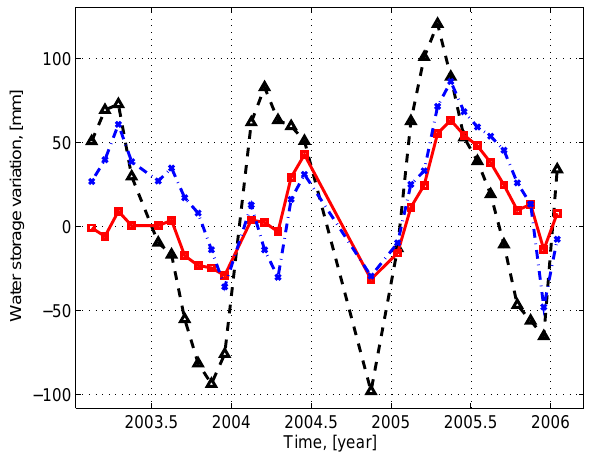
Fig. 11. Differences of water storage variations from CPC-LDAS and GRACE for the period January 2003 until December 2005. Up- per Zambezi target area. Gaussian filter with 1000km correlation length. Black triangles: CPC-LDAS – GRACE; red squares: CPC- LDAS – GRACE/CPC; blue crosses: CPC-LDAS – GRACE/LEW.